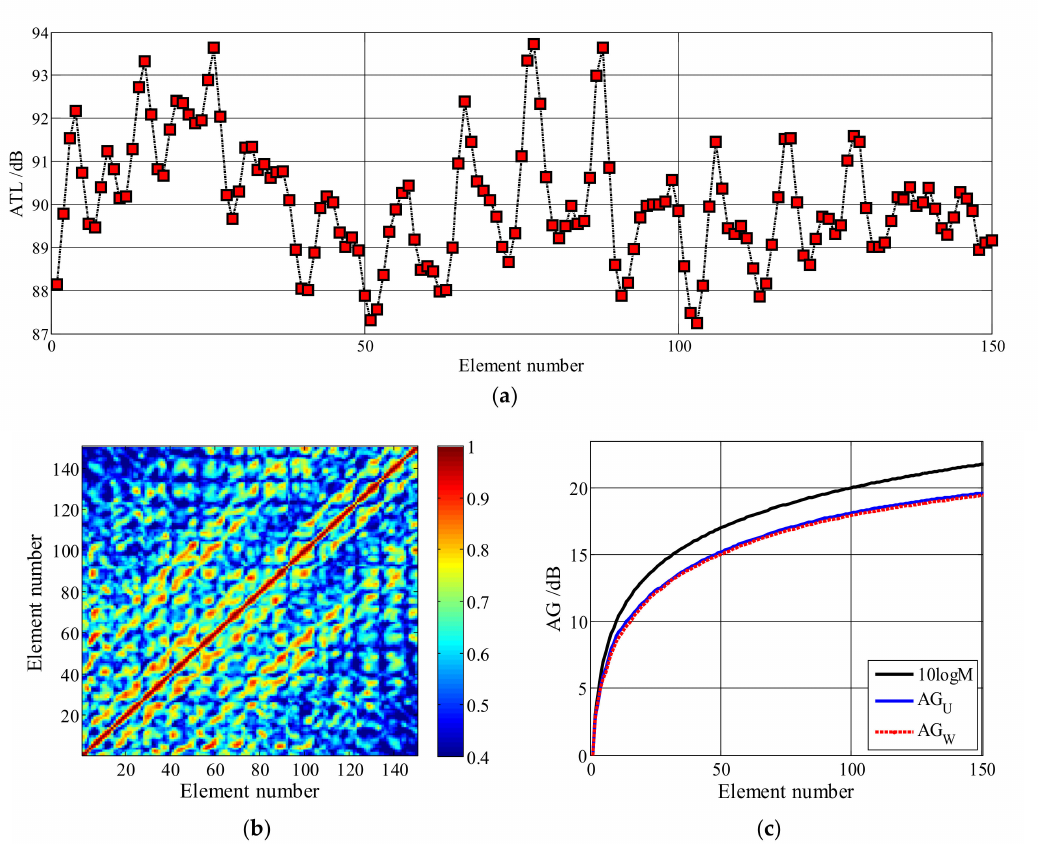
Figure 5. Fluctuant acoustic channels and AGs for the receiving depth of 120 m and distance of 20 km in the deep sea: ( a ) ATL s on the elements; ( b ) Correlation coefficients; ( c ) AG U (blue solid line), AG W (red dash line) and the ideal value of AG (black solid line) varying with the element